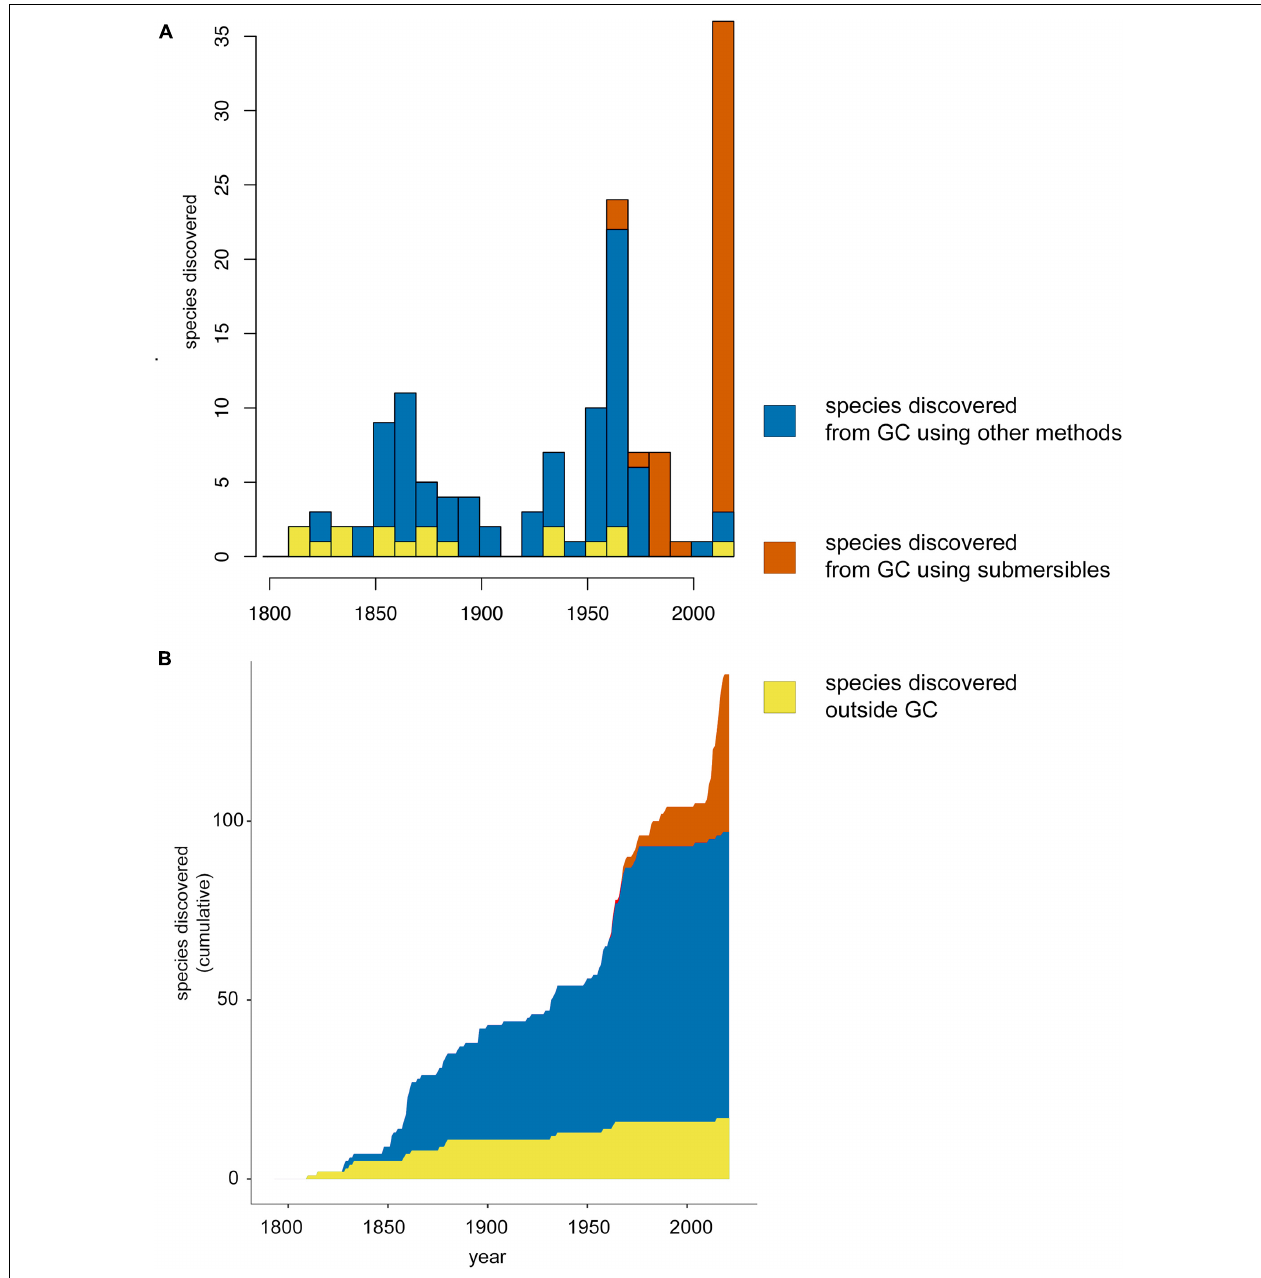
FIGURE 4 | The historical dynamics of discovery of deep-reef fishes known from the Greater Caribbean. (A) Number of non-pelagic species discovered (i.e., first type specimens collected) per decade. (B) Cumulative discovery of those three classes of deep-reef fishes.